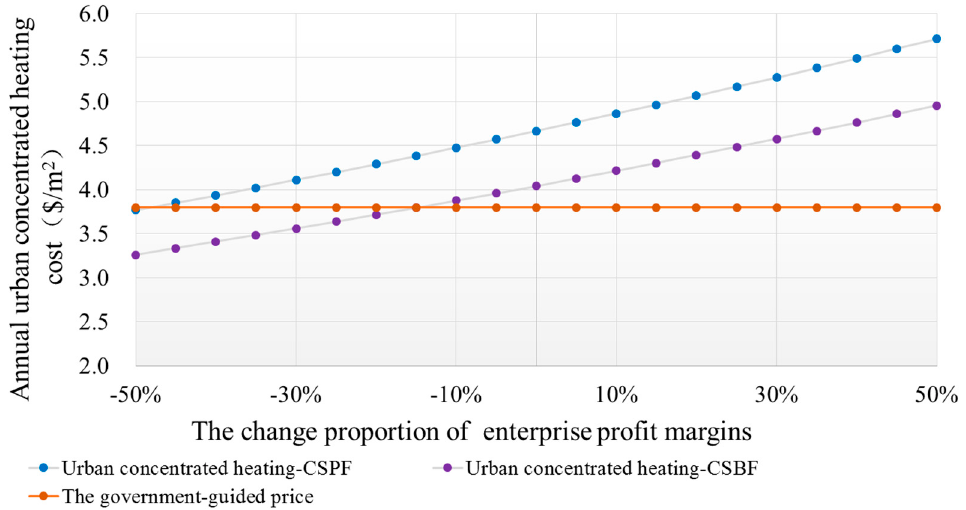
Figure 12. Influence of enterprise profit margin on the economic performance of CSDF for urban concentrated heating.